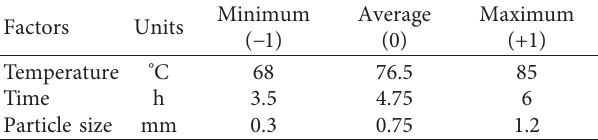
Table 1: Levels of chosen parameters for experimental